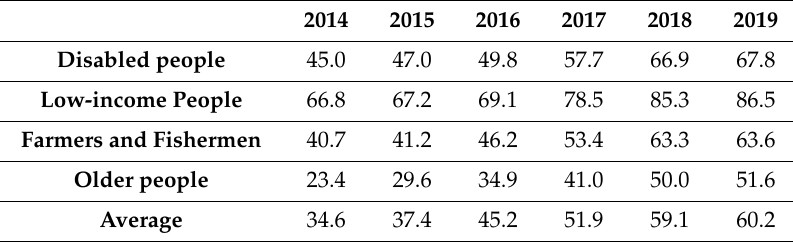
Table 7. Digital Capacity Level of four groups.